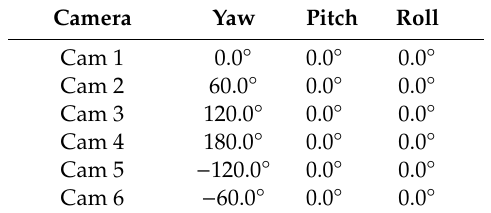
Table 2. Initial orientation of cameras for mono data acquisition.